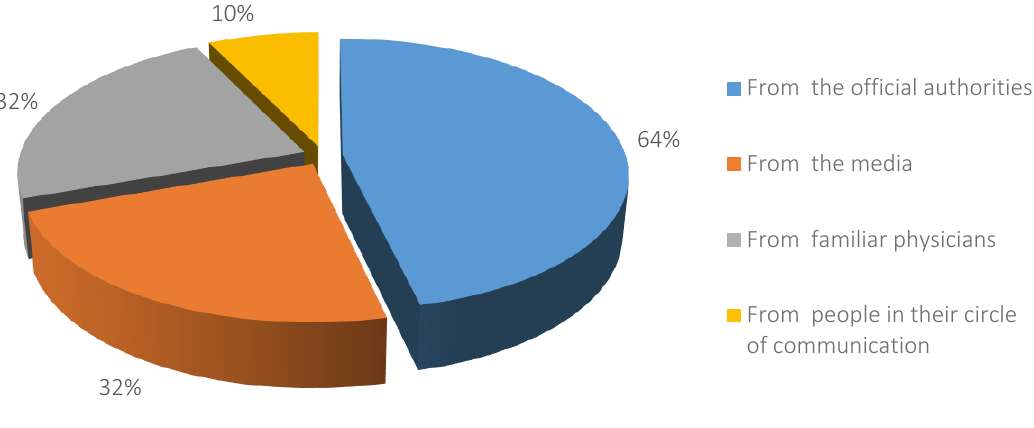
Figure 7. Sources of information that are most trusted by respondents